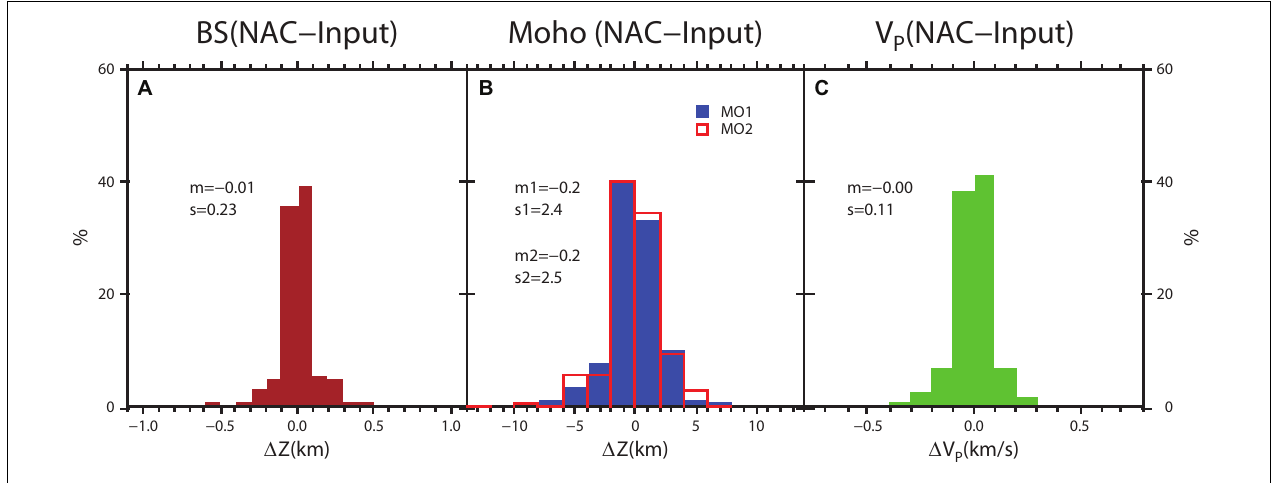
FIGURE 8 | Histograms of the differences between NAC and input values: (A) BS interface; (B) MO1 and MO2 interfaces; (C) V P .